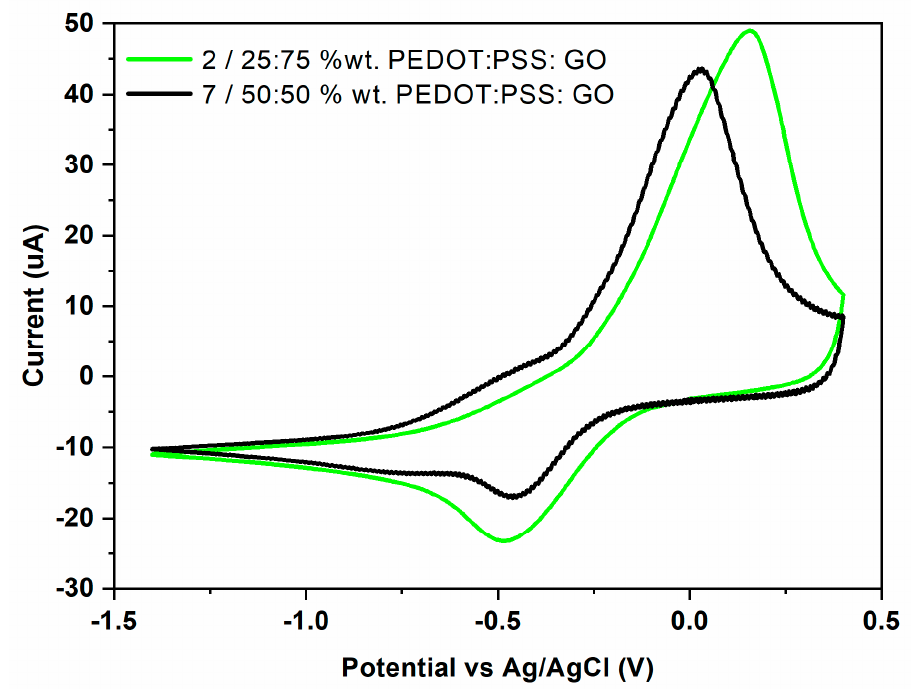
Figure 7. Cyclic voltammogram of Cu 2+ (100 ppm) in 0.1 M acetate buffer solution (pH = 5.0 upH) recorded on PEDOT:PSS: GO sensors with different polymer: graphene oxide ratios, i.e., graph 2 = 25:75 % wt. PEDOT:PSS: GO, and graph 7 = 50:50% wt. PEDOT:PSS: GO.